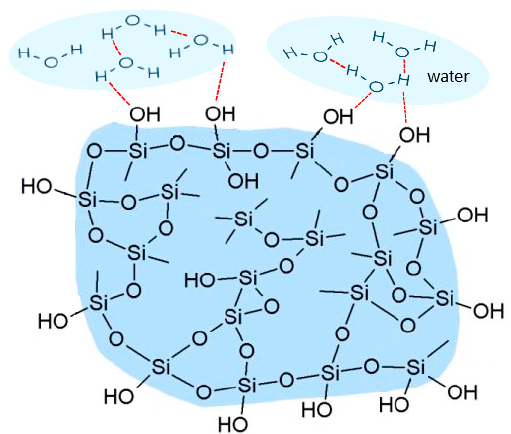
Figure 1. Schematic illustration of the silica gel structure with the hydrogen bonding shown in